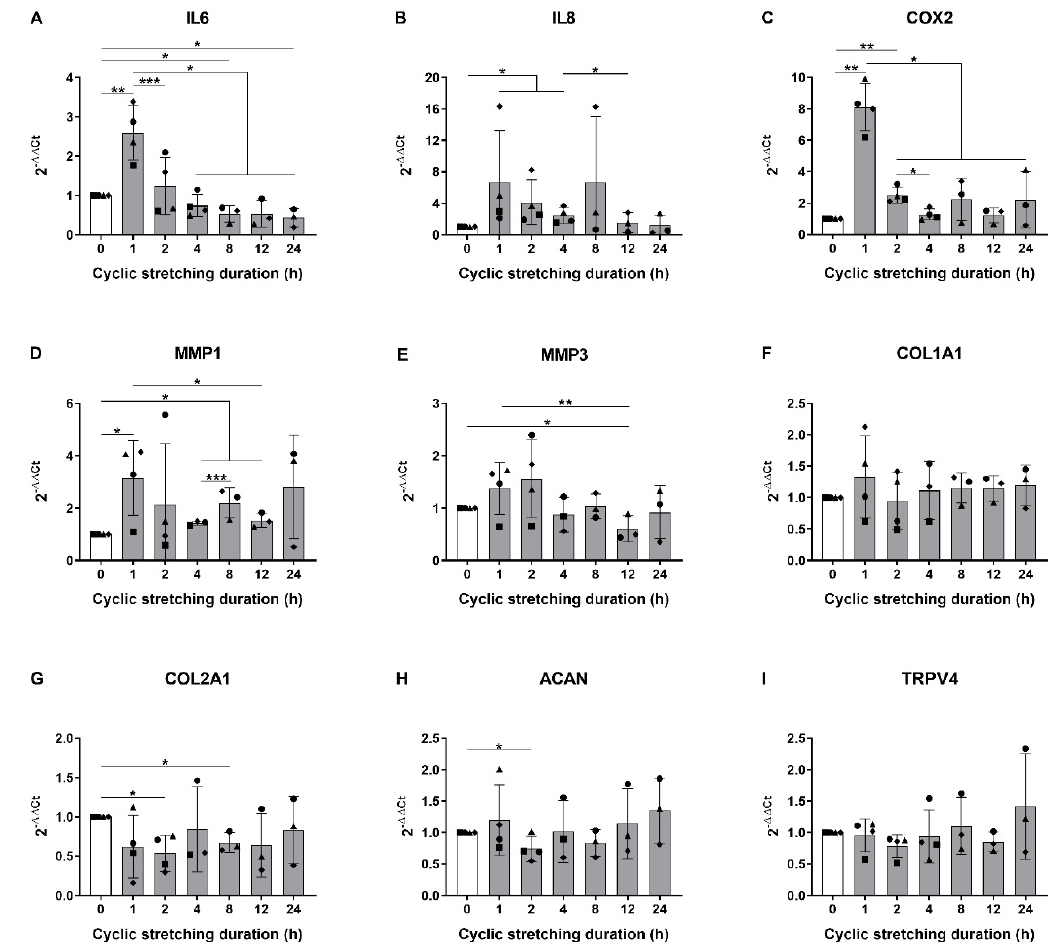
Figure 1. Gene expression of ( A – C ) pro-inflammatory mediators; ( D , E ) matrix metalloproteinases; ( F – H ) extracellular matrix; and ( I ) TRPV4 immediately after 0 (white bar) or from 1 to 24 h (grey bars) of cyclic stretching at 20% strain and 1 Hz. n = 3–4 donors; mean ± SD; * p < 0.05, ** p < 0.01, *** p < 0.001.